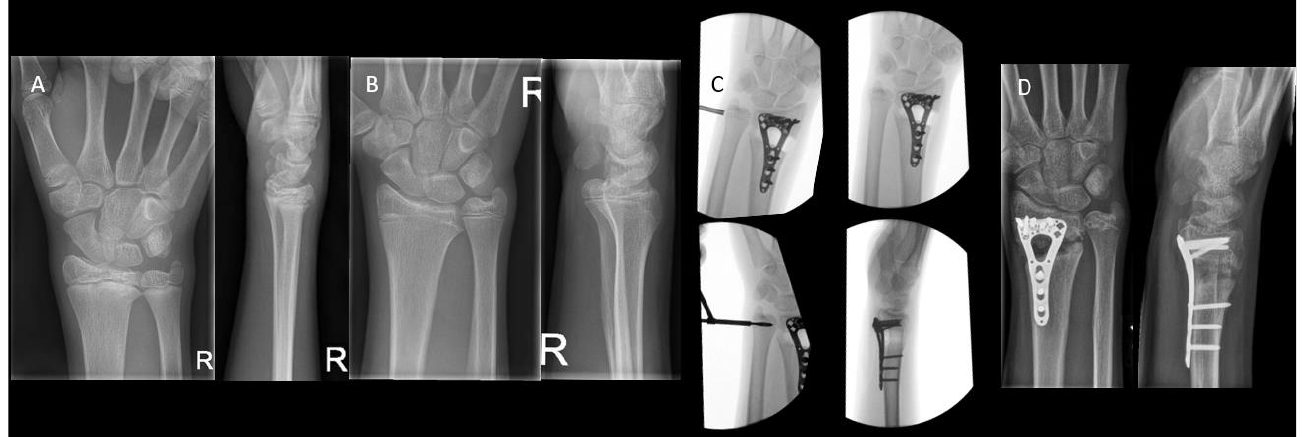
Figure 9. ( A ) A 17-year-old boy with a traumatic premature closure of the distal radial physis. ( B ) A closed radial physis, accompanied by an ulna plus. ( C ) Intraoperative radiographs during correction osteotomy of the radius combined with an epiphysiodesis of the ulna. ( D ) Radiographs six weeks postoperatively.